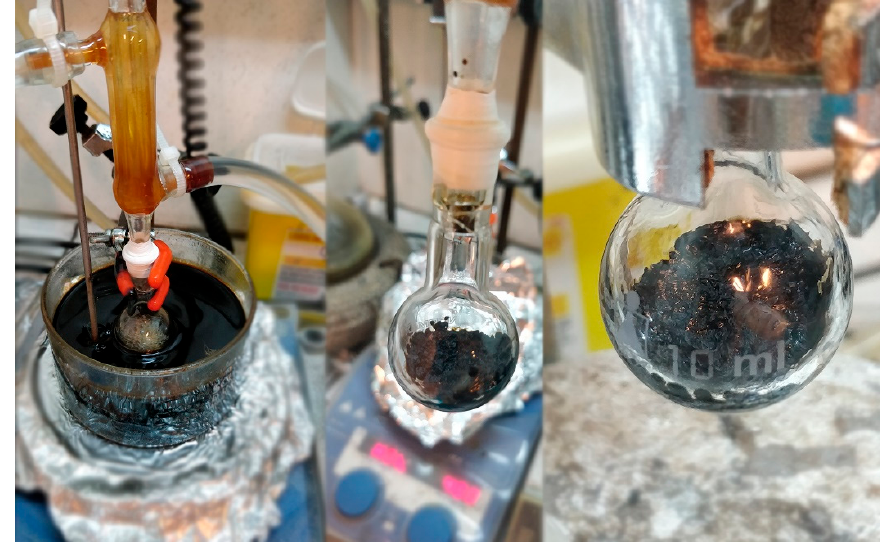
Figure A2. Appearance of the reaction mixture during reflux ( left ) and after cooling down to room temperature ( center and right ).